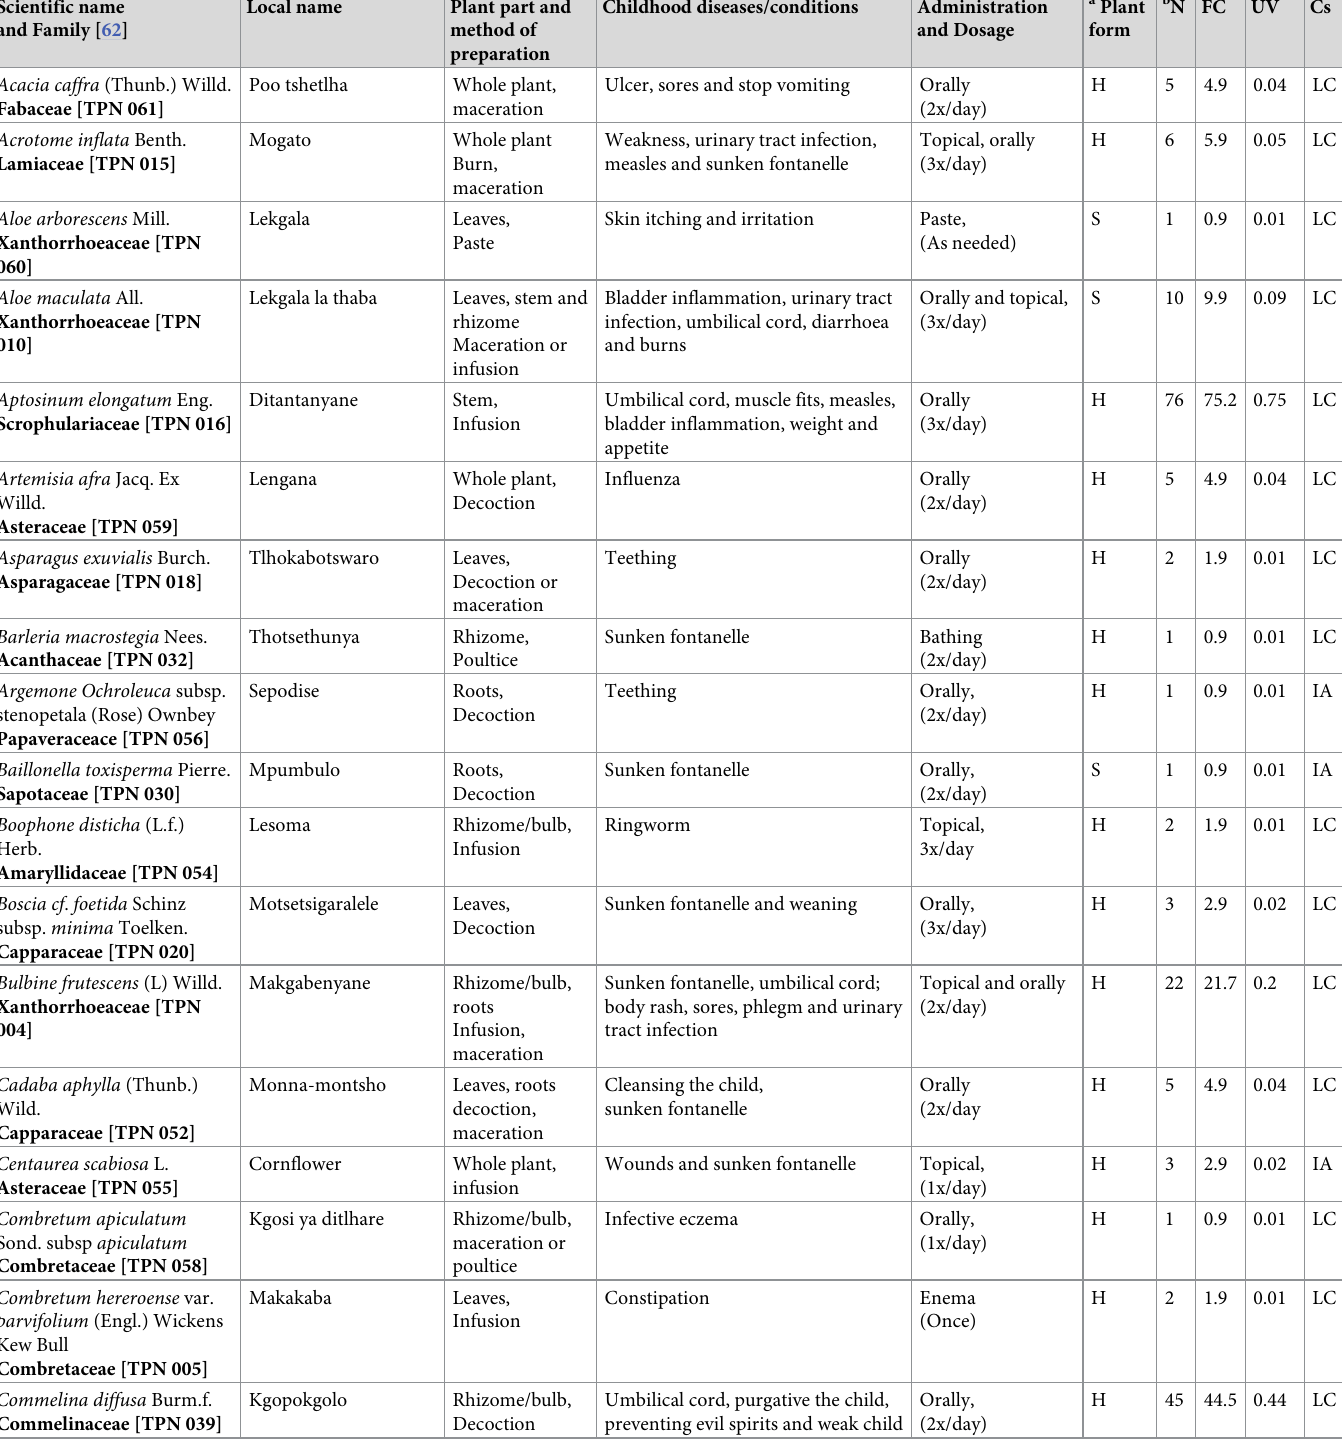
Table 3. Ethno-botanical information on plants used for the treatment and management of childhood diseases and general well-being in Ngaka Modiri Molema and Bojanala districts of North West Province, South